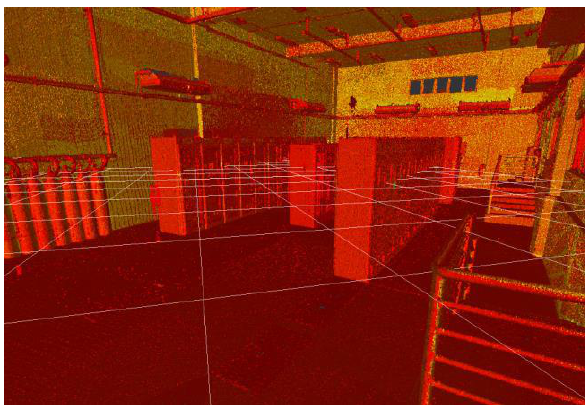
Figure 5: Registered point cloud data